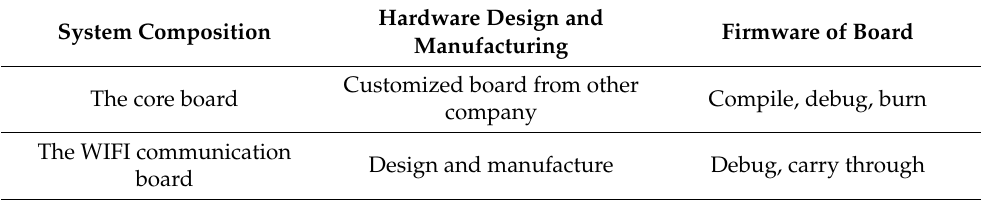
Table 2. The main contributions we made in the hardware and firmware.